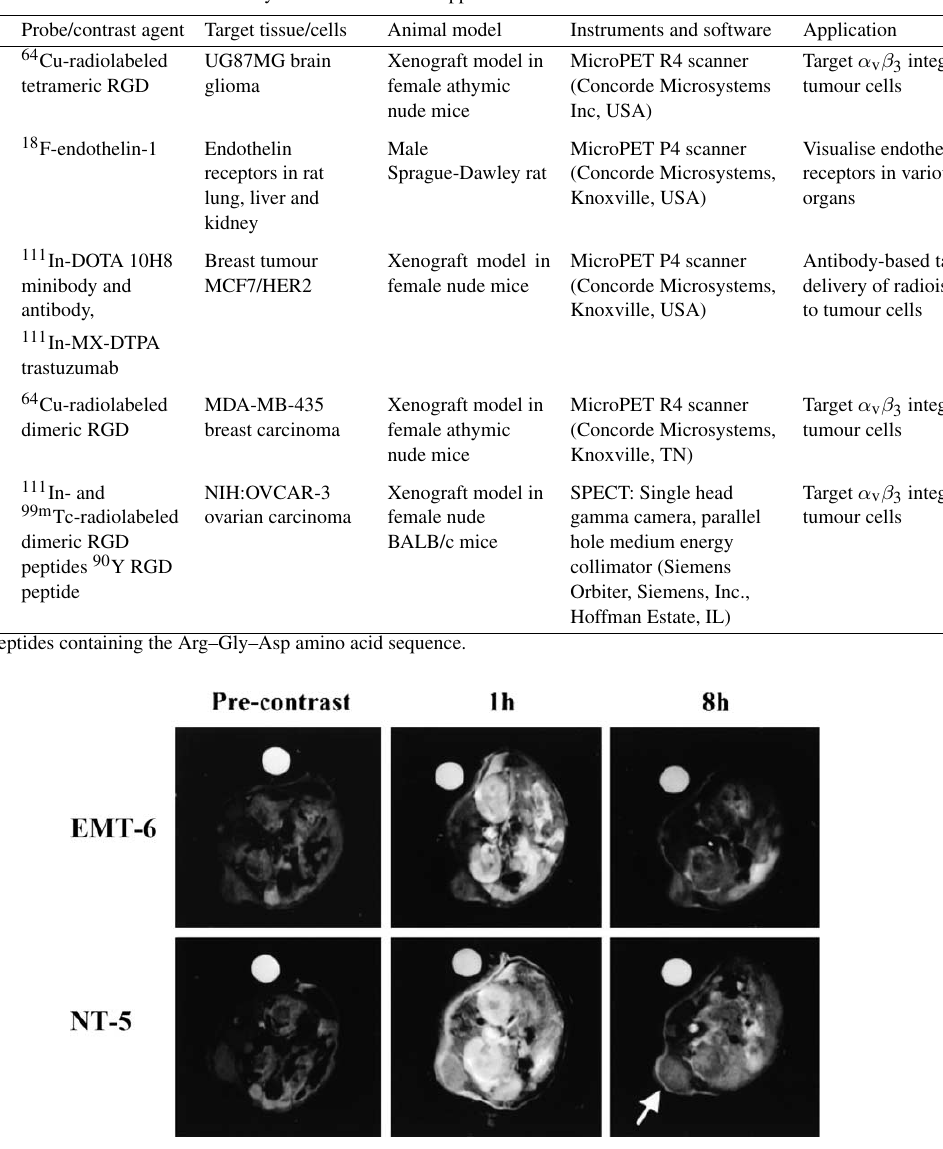
Fig. 3. MR T1-weighted images of control EMT-6 (which do not express HER-2/ neu ) and NT-5 tumours (labelled with a biotinylated monoclonal antibody to HER-2/neu) obtained before administration of the contrast agent (avidin-GdDTPA conjugate) and at 1 h, 8 h after contrast. Arrows show enhanced signal from the tumour at the 8 h time point for the HER-2/ neu expressing NT-5 tumour